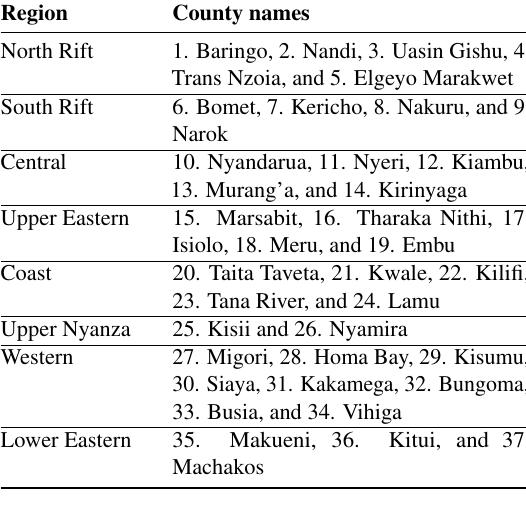
Figure 2. Regional distribution of maize yield data acquired be- tween 2010–2017.